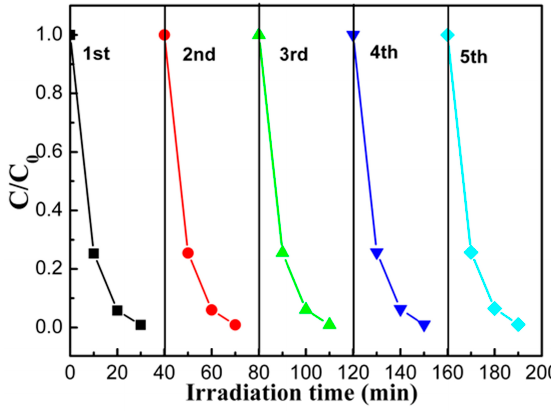
Figure 9. Cycling runs in the photocatalytic degradation of MB in the presence of N 0.45 B 0.55 sample. It is essential to investigate the proposed mechanism for a heterostructure photocatalyst system.